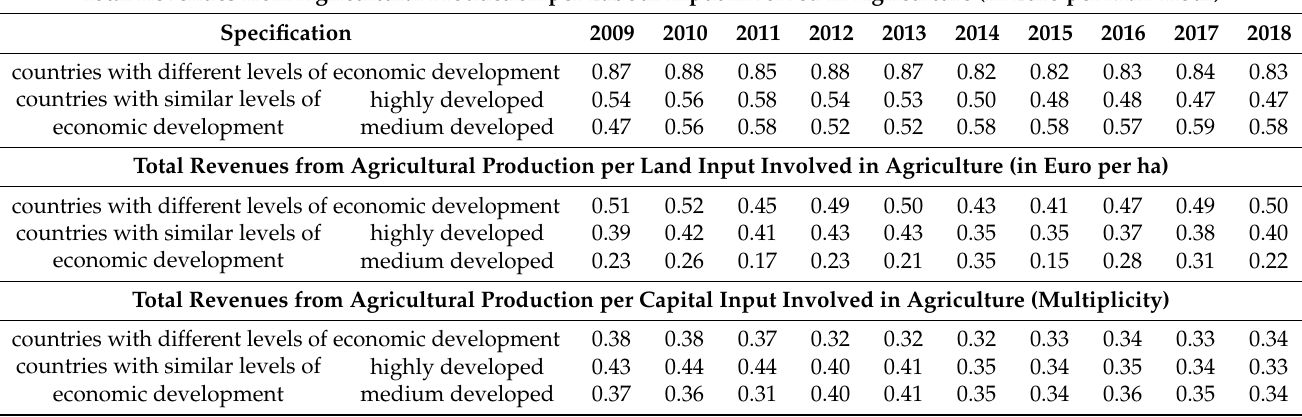
Table 12. Sigma coefficients ( σ )-convergence in the examined EU countries with different and similar levels of economic development in relation to total revenues from agricultural production per: labour input involved in agriculture (in euro per man-hour); land input involved in agriculture (in euro per ha) and per capital input involved in agriculture (multiplicity). Total Revenues from Agricultural Production per Labour Input Involved in Agriculture (in Euro per